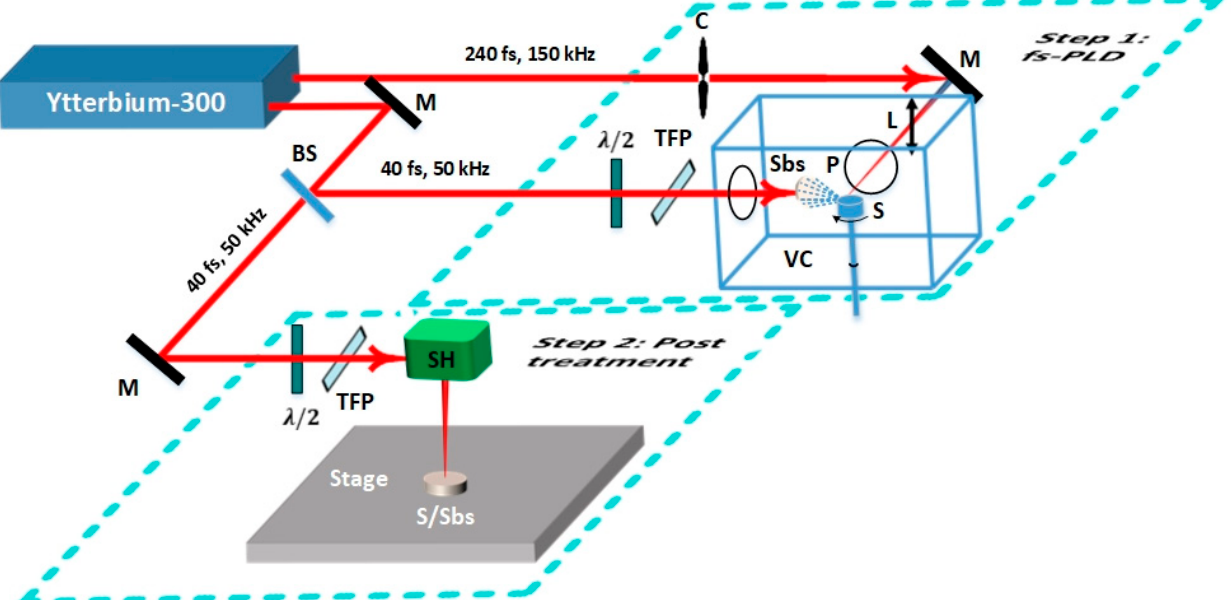
Figure 1. Schematic diagram of the experimental setup: Step 1—femtosecond pulsed laser deposition of the source material, Step 2—post treatment of the sample in step 1 using scan head, Ytterbium- 300—300 W ytterbium laser with 240 fs, 150 kHz and 40 fs, 50 kHz laser beams, C—Optical chopper, M—dielectric mirror, L—objective lens, VC—vacuum chamber, S—source material wrapped around a rotating cylindrical holder, P—plasma plume, Sbs—substrate, BS—beam splitter, λ /2—half wave plate, TFP—thin film polarizer, SH—scan head, S/Sbs—source material deposited over the substrate via fs-PLD, Stage— z -axis translation